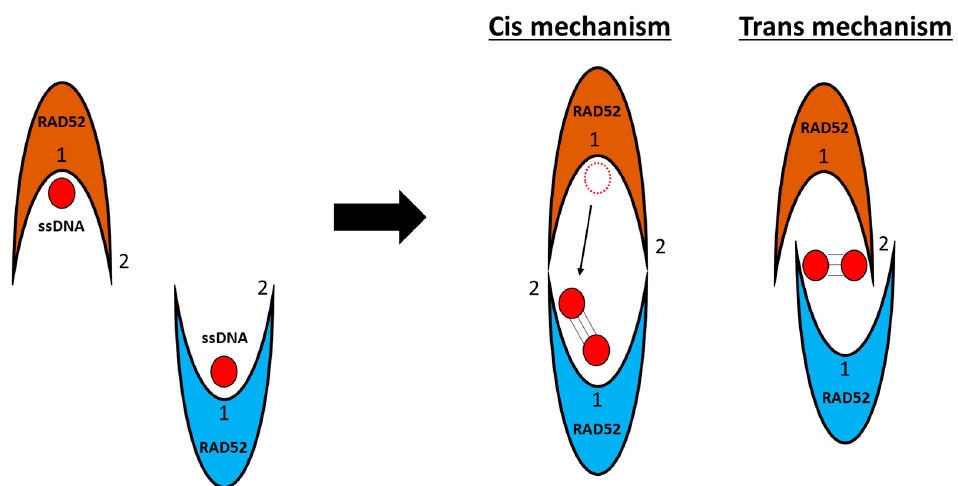
Figure 9. Schematic representation of the two postulated cis and trans mechanisms of RAD52- mediated homology search. The dashed line circle represents the original position of one of the two DNA strands in the deep inner binding groove (1) of one of the two nucleoproteins that is then temporarily placed in the second binding site (2) of the second nucleoprotein upon homology search (solid line